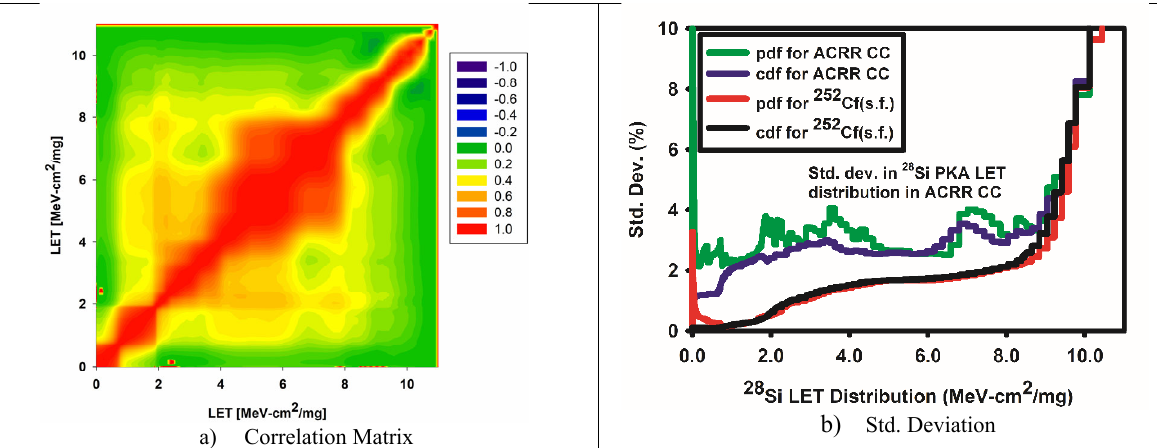
Fig. 12. Silicon LET distribution for two neutron spectra [8]